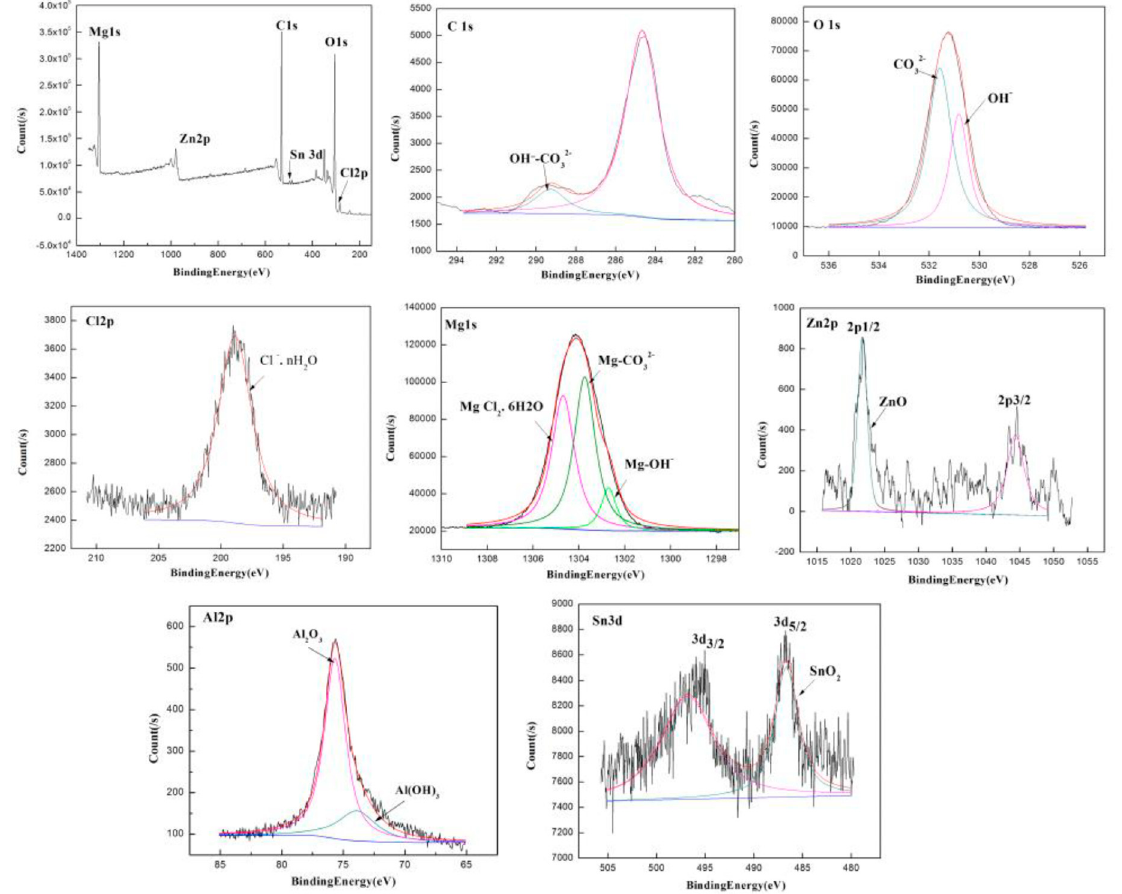
Figure 10. X-ray photoelectron spectroscopy (XPS) analysis results of ZAT543 alloy immersed in 3.5 wt % NaCl for 48 h.